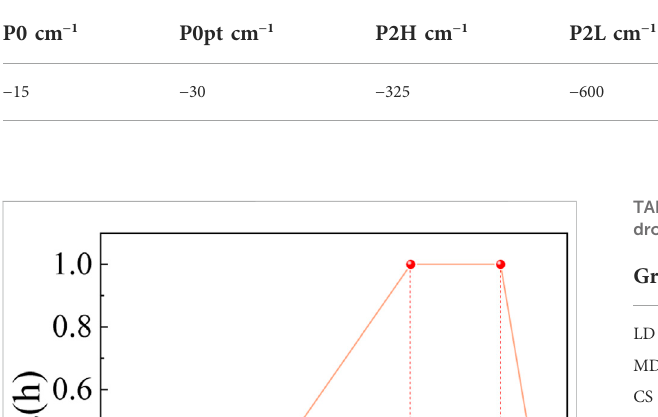
TABLE 4 Water absorption parameters of maize roots.